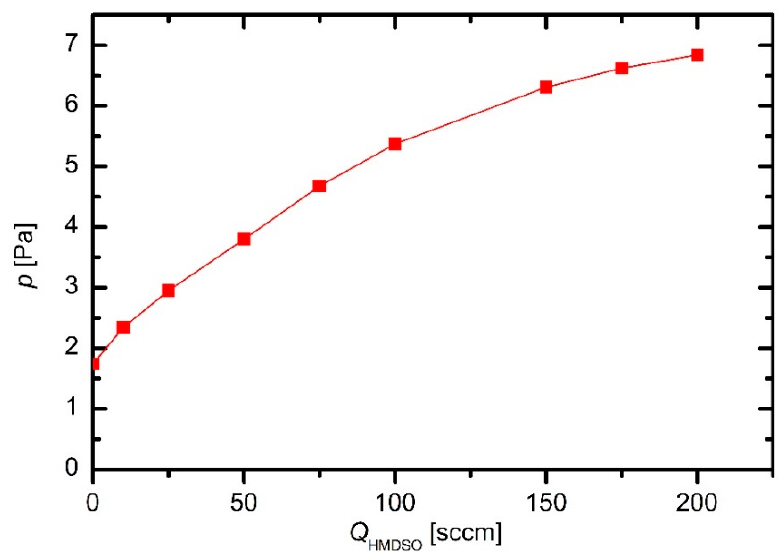
Figure 1. The pressure in the plasma reactor versus the hexamethyldisilioxane (HMDSO) flow.